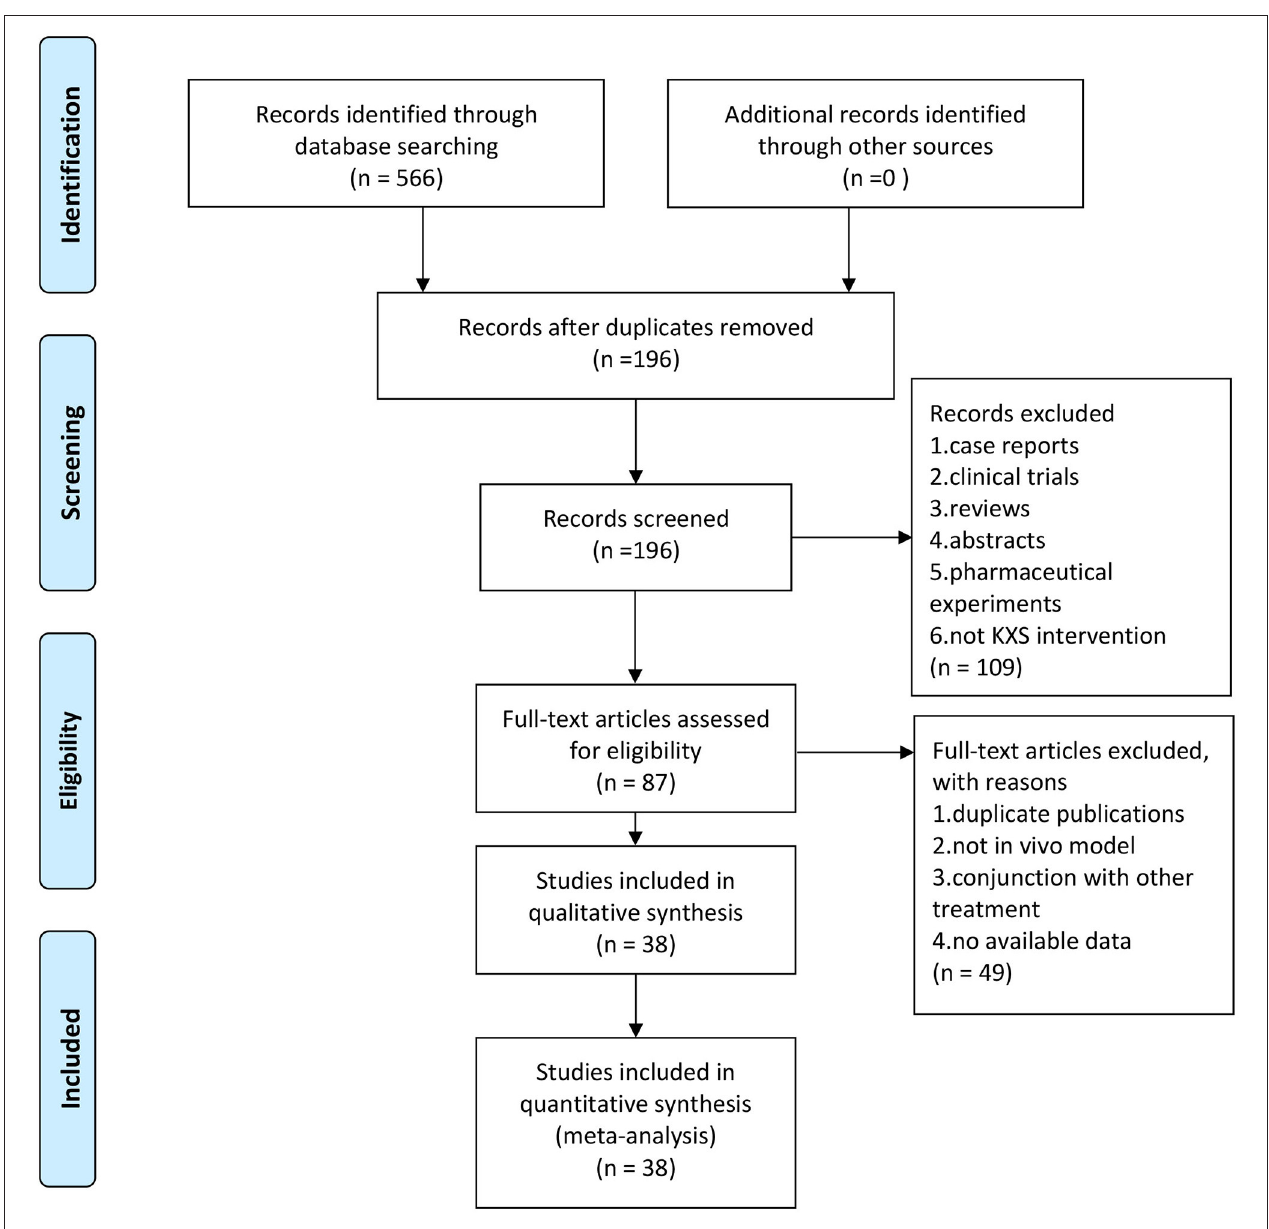
FIGURE 1 | The PRIMSA flow diagram of study